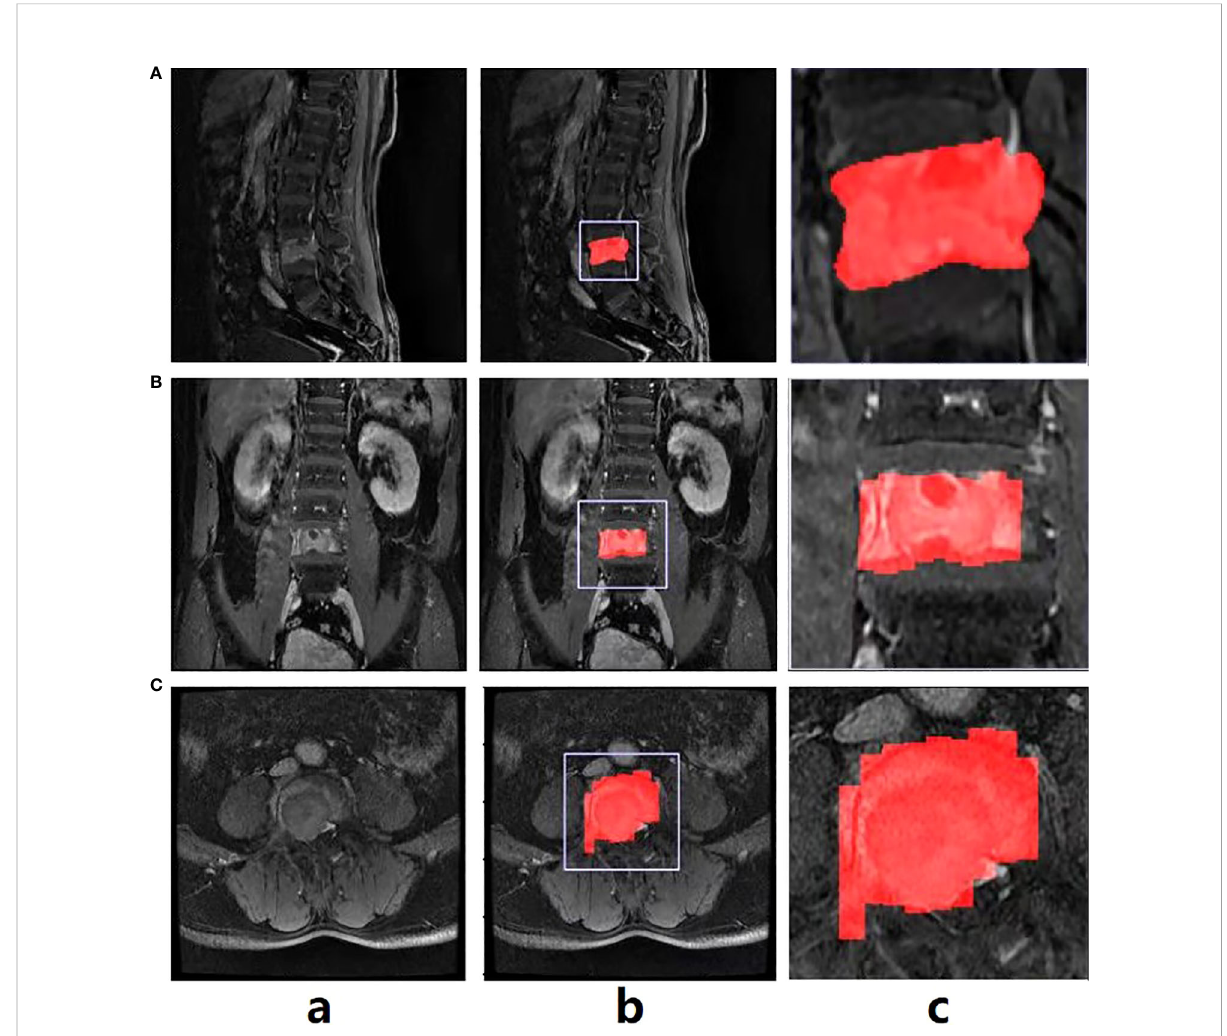
FIGURE 2 The exemplar spinal image with annotation in the sagittal view (A) , and the annotation transfer to the coronal (B) and axial views (C) using af fi ne